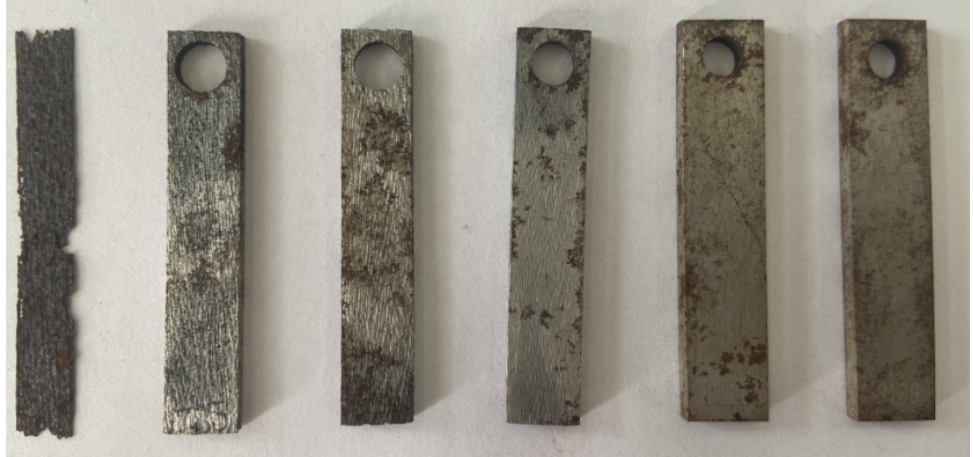
Figure 8. Photographs of N80 steel sheet corrosion (left to right: 0%, 0.5%, 0.8%, 1.0%, 1.5%, and 2.0%).